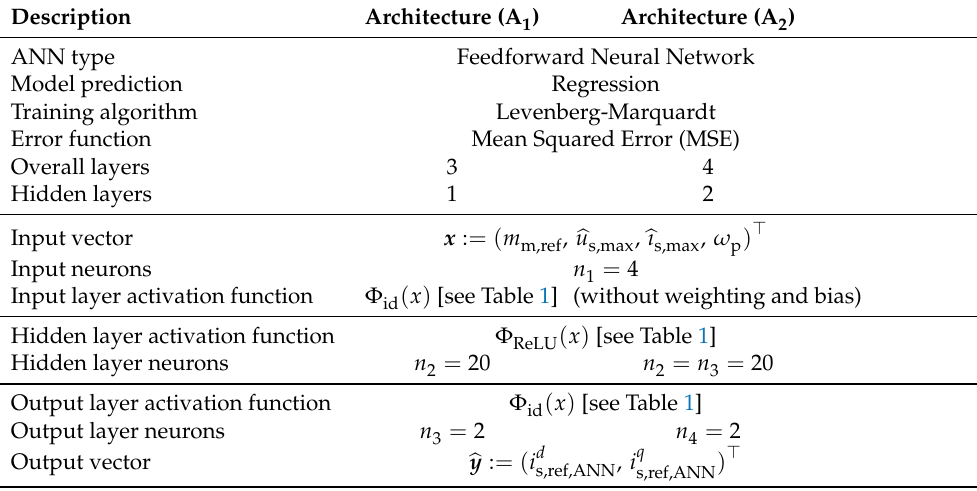
Figure 9. Illustration of the two implemented ANN architectures: Each architecture has four input layer neurons and two output layer neurons; Architecture (A 1 ) has one hidden layer, whereas Architecture (A 2 ) has two hidden layers with 20 hidden layer neurons each. Table 2. Key data of implemented ANN architectures (centered entries hold for both architectures).